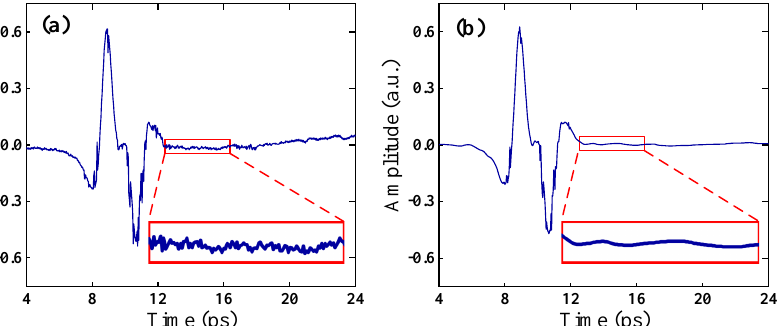
Figure 1. ( a ) Original terahertz time–domain signal, ( b ) denoised signal based on improved wavelet denoising method. Insets show a zoomed region.